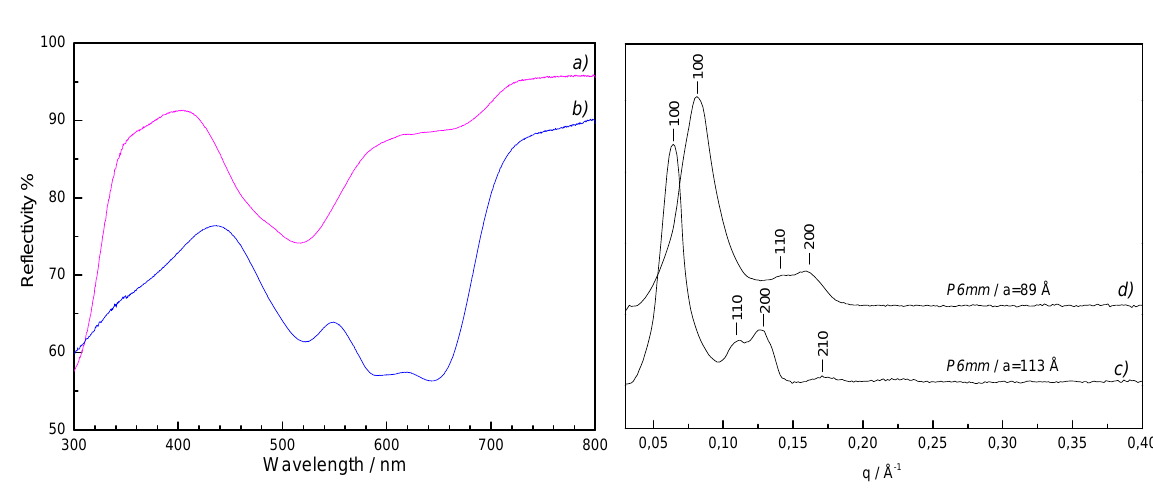
Figure 6. On the left UV-visible spectra of the Co(II)-containing silica monoliths ( a ) before and ( b ) after thermal treatment at 500 °C. On the right, small angle XRD patterns of the Co(II)-containing silica monoliths ( c ) before and ( d ) after thermal treatment at 500